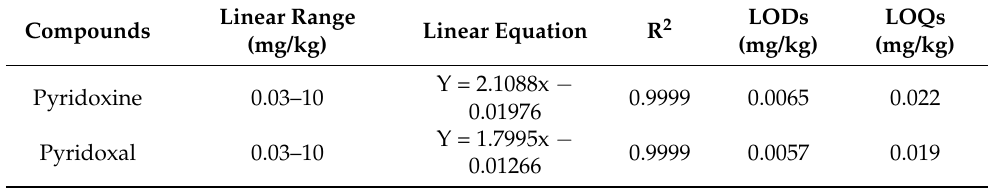
Table 1. Linear equation, limit of detection and limit of quantification of pyridoxal and pyridoxine. Compounds